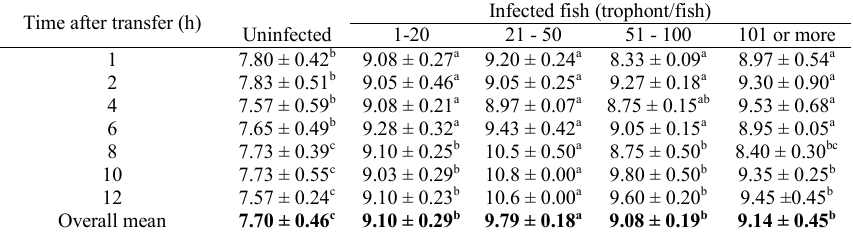
Table 2. Preferred pH of silver catfish infected with Ichthyophthirius multifiliis acclimated to water hardness of 24 mg CaCO L -1 . Values are reported as mean ± SEM. Means identified by different letters in the rows were significantly different ( P < 0.05) as determined by ANOVA and Tukey’s comparison of mean